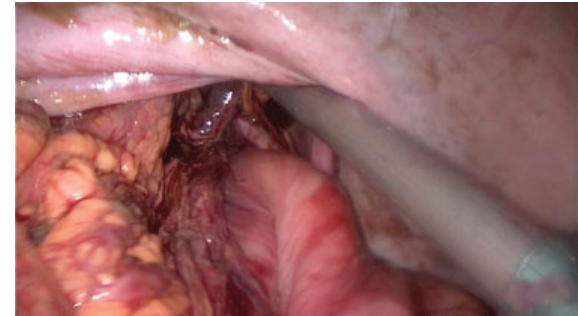
Fig. 2 Thoracic CTscan on admission. Left-sided tension pneumothorax with mediastinal shift. No further signs of a traumatic etiology. CT, computed tomography.